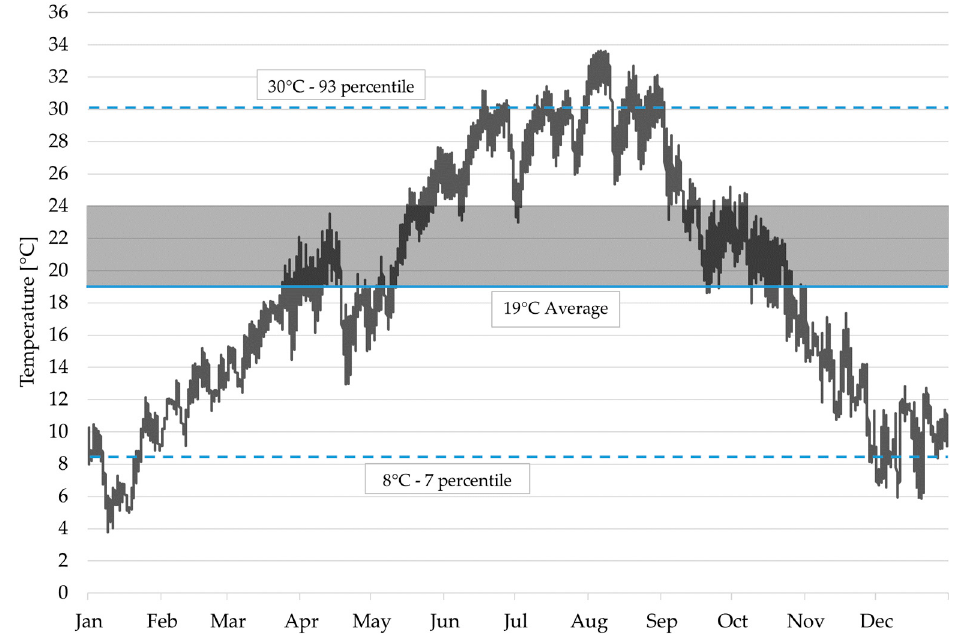
Figure 13. Trend of historic climate hourly values of T and statistical limits of 93rd and seventh percentiles in position A vs. the range recommended by the Italian D.M. 10.05.2001 [16] (gray band).